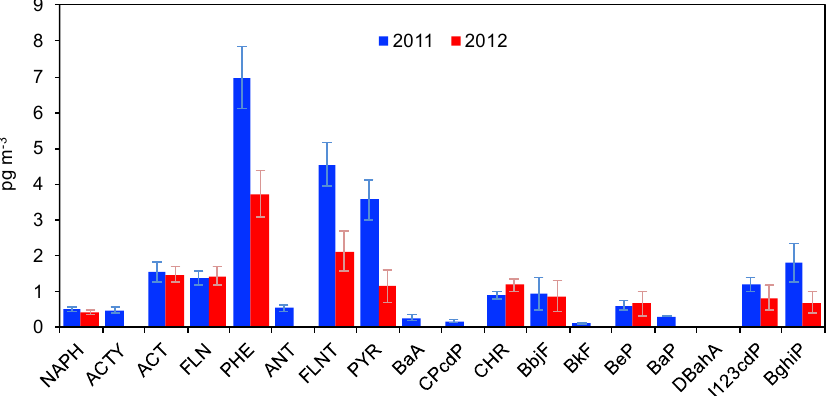
Figure 10. PAHs pattern in particulate matter phase during both AREX2011 and AREX2012.